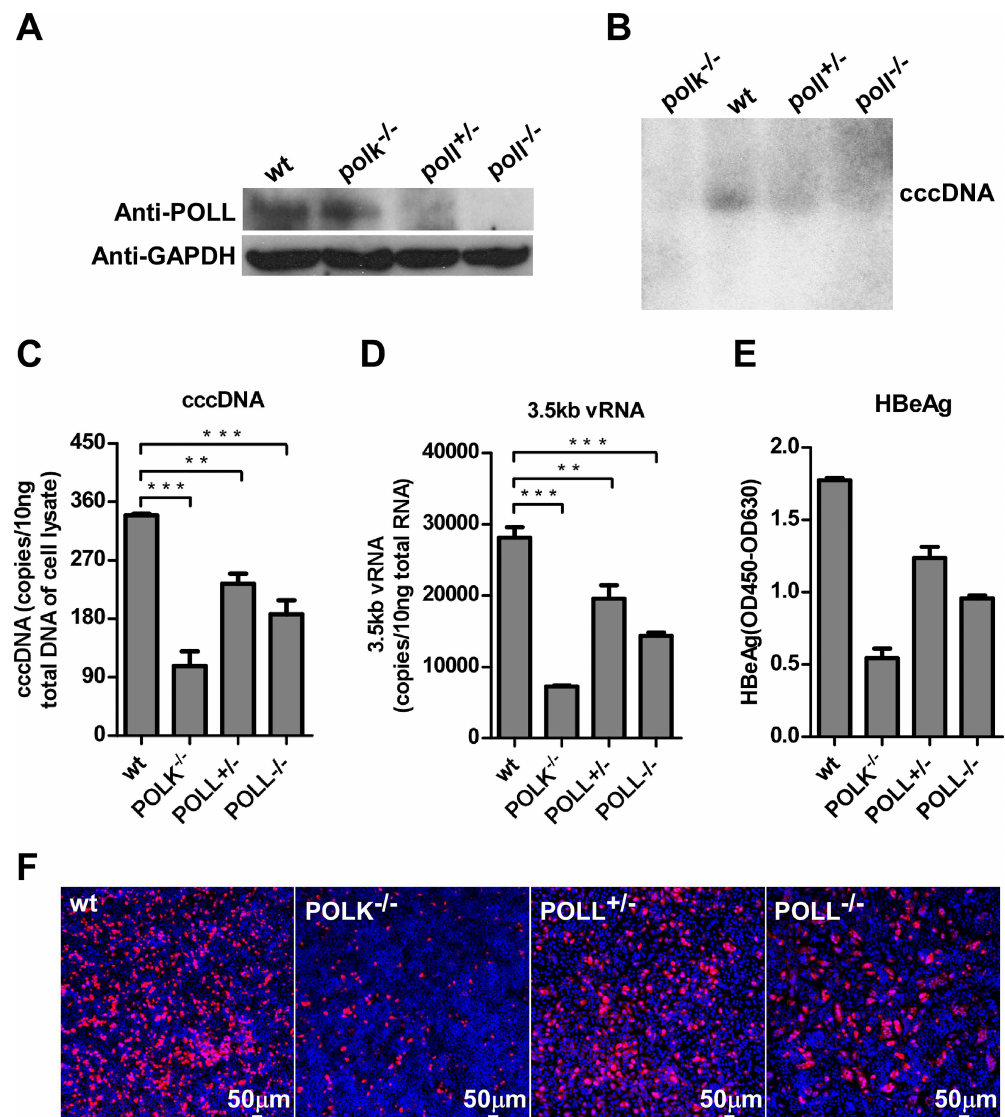
Fig 7. Depletion of POLL reduces HBV cccDNA synthesis. (A) POLL expression in parental HepG2-NTCP cells (wt), POLK deficient cells (HepG2-NTCP polk-/- ) and HepG2-NTCP cell clones bearingdisrupted poll gene in one (HepG2-NTCP poll+/- ) or both alleles (HepG2-NTCP poll-/- ) was determinedby a Western blot assay. GAPDH protein served as a loadingcontrol. (B-F) The indicatedHepG2-NTCP-derived cell lines were infected with HBV. HBV cccDNA on 7 dpi was detected by Southernblot (B). The amounts of cccDNA (C) and 3.5kb vRNA (D) on 7 dpi were measured by qPCR assays. Data were analyzedby an unpairedtwo-tailed t test. ** p < 0.01 and *** p < 0.001. Secreted HBeAg from the indicatedHepG2-NTCP cells on 7 dpi was measured by ELISA (E). HBcAg in the infected cultures was stained with 1C10 mcAb (red). Nuclei were stained with DAPI (blue) (F). Images were captured with a Nikon A1-R confocal microscopy. Scale bars, 50 μ